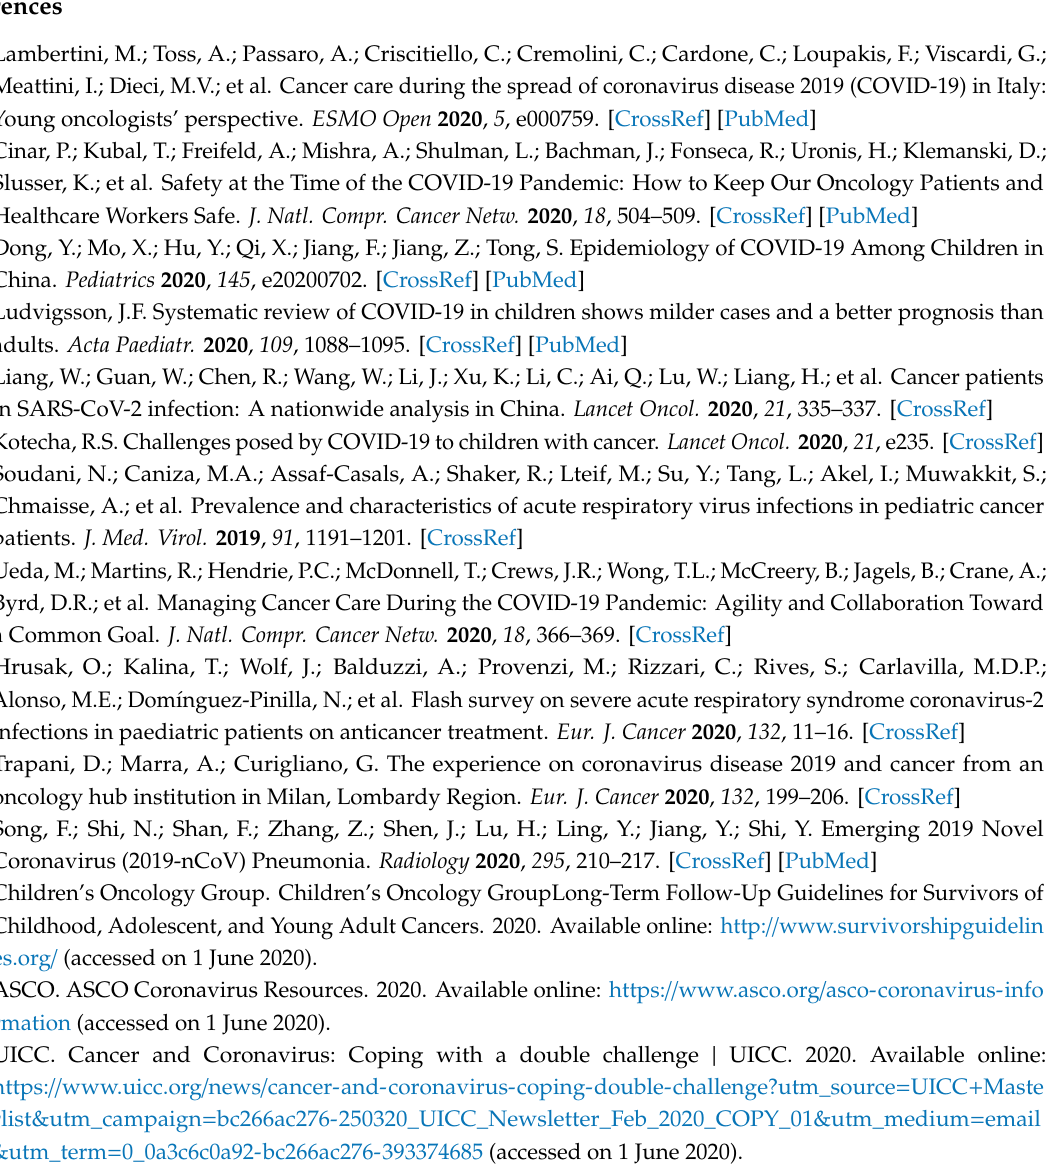
Table S1: Search strategy. Figure S1: Flow chart of the literature review. Table S2: COVID-19 interventions by description in the included